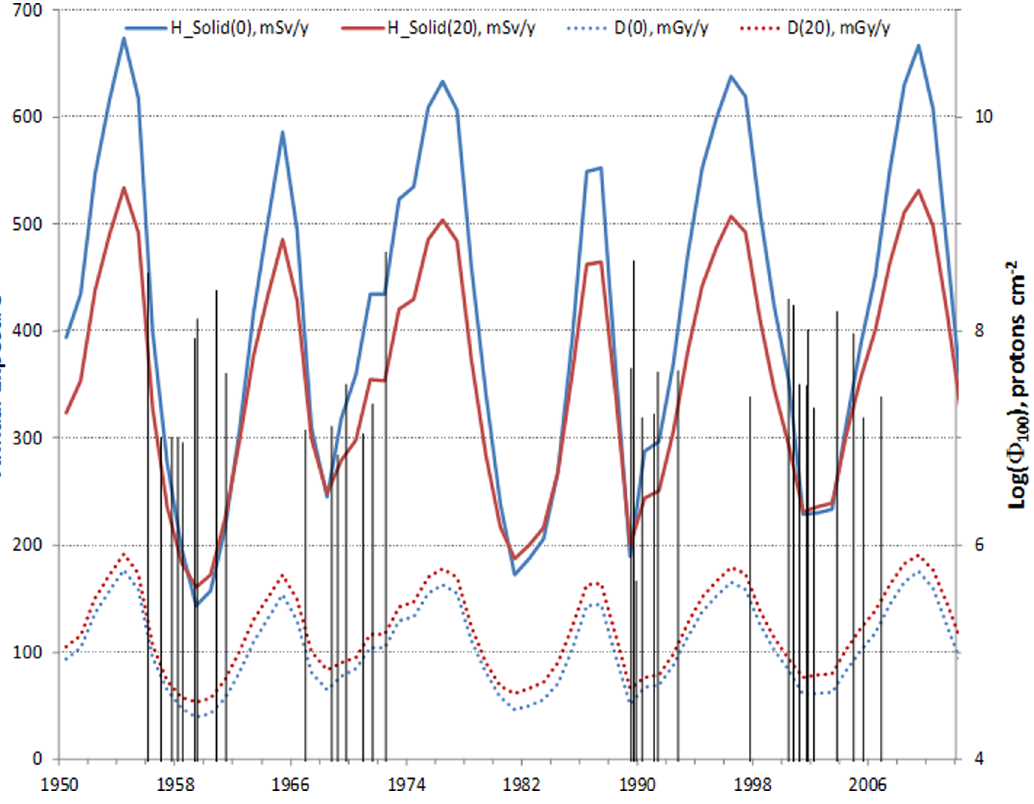
Figure 3. Estimates of the GCR organ doses over recent solar cycles at 0 and 20 g/cm 2 of aluminum shielding (left axis) and the log of the 100 MeV integral proton fluence, which was shown to be a useful predictor of SPE organ doses after considering their variable energy spectra ( 11 ) (right axis).